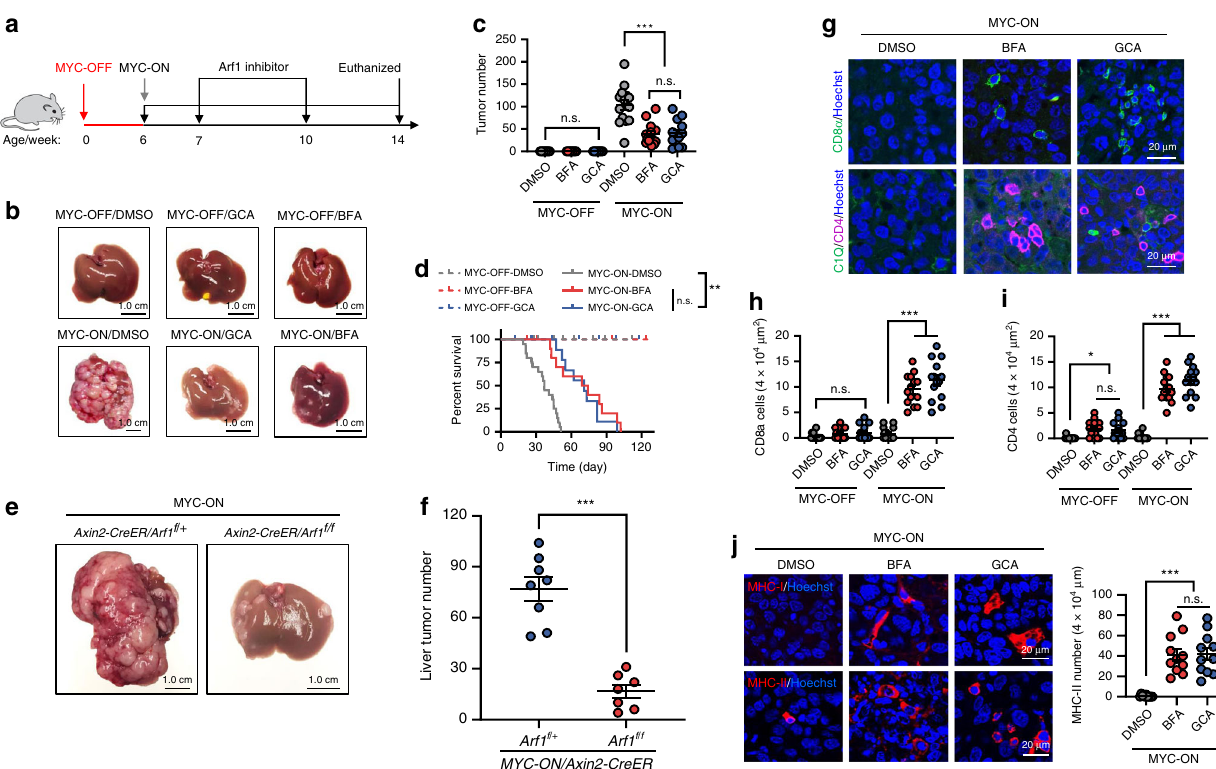
Fig. 3 Arf1 inhibition induces anti-tumor immune responses in MYC-ON liver tumor mice. a Experimental setup for the MYC-ON mice. b Representative liver images of MYC-OFF or MYC-ON mice treated with DMSO, GCA, or BFA. c , d Liver surface tumor counts ( c ) and survival curves ( d ) of mice with the indicated treatments ( n = 15 mice each group; *** p < 0.001, t -test; pooled two independent experiments). e Representative liver images of MYC-ON/ Axin2-CreER/Arf1 f/ + or MYC-ON/Axin2-CreER/Arf1 f/f mice. f Liver surface tumor counts of e ( n = 8 mice each group; *** p < 0.001, t -test; polled repeat two independent times). g – i Arf1 inhibition induces the expression of CD8 and CD4 in the liver of MYC-ON liver tumor mice ( n = 13 mice each group; *** p < 0.001, t -test; polled repeat three independent times). j Arf1 inhibition induces the expression of MHC-I and MHC II in the liver of MYC-ON liver tumor mice ( n = 13 mice each group; *** p < 0.001, t -test; polled repeat three independent times). Data are shown as the mean ± SEM. * p < 0.05, ** p < 0.01, *** p < 0.001 by Student ’ s t -test. Scale bars are as